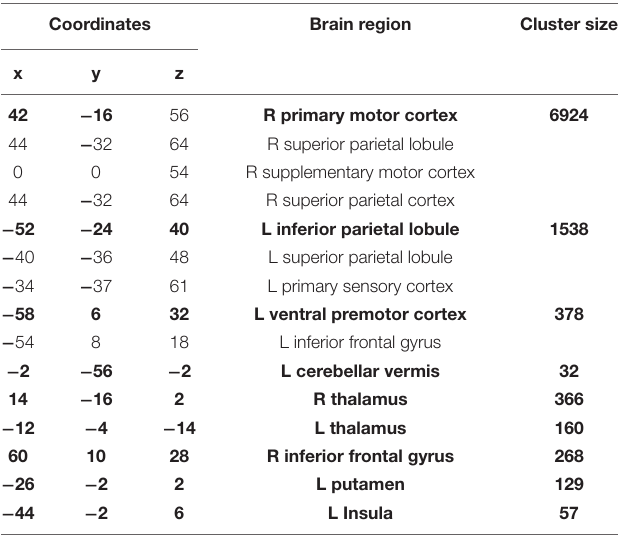
TABLE 1 | Task activations for the conjunction analysis between complex and simple task.